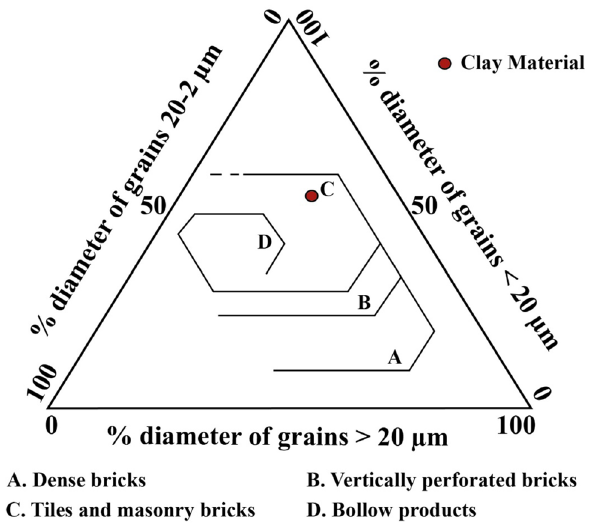
Fig. 4 Position of clay material in Winkler diagram [19]